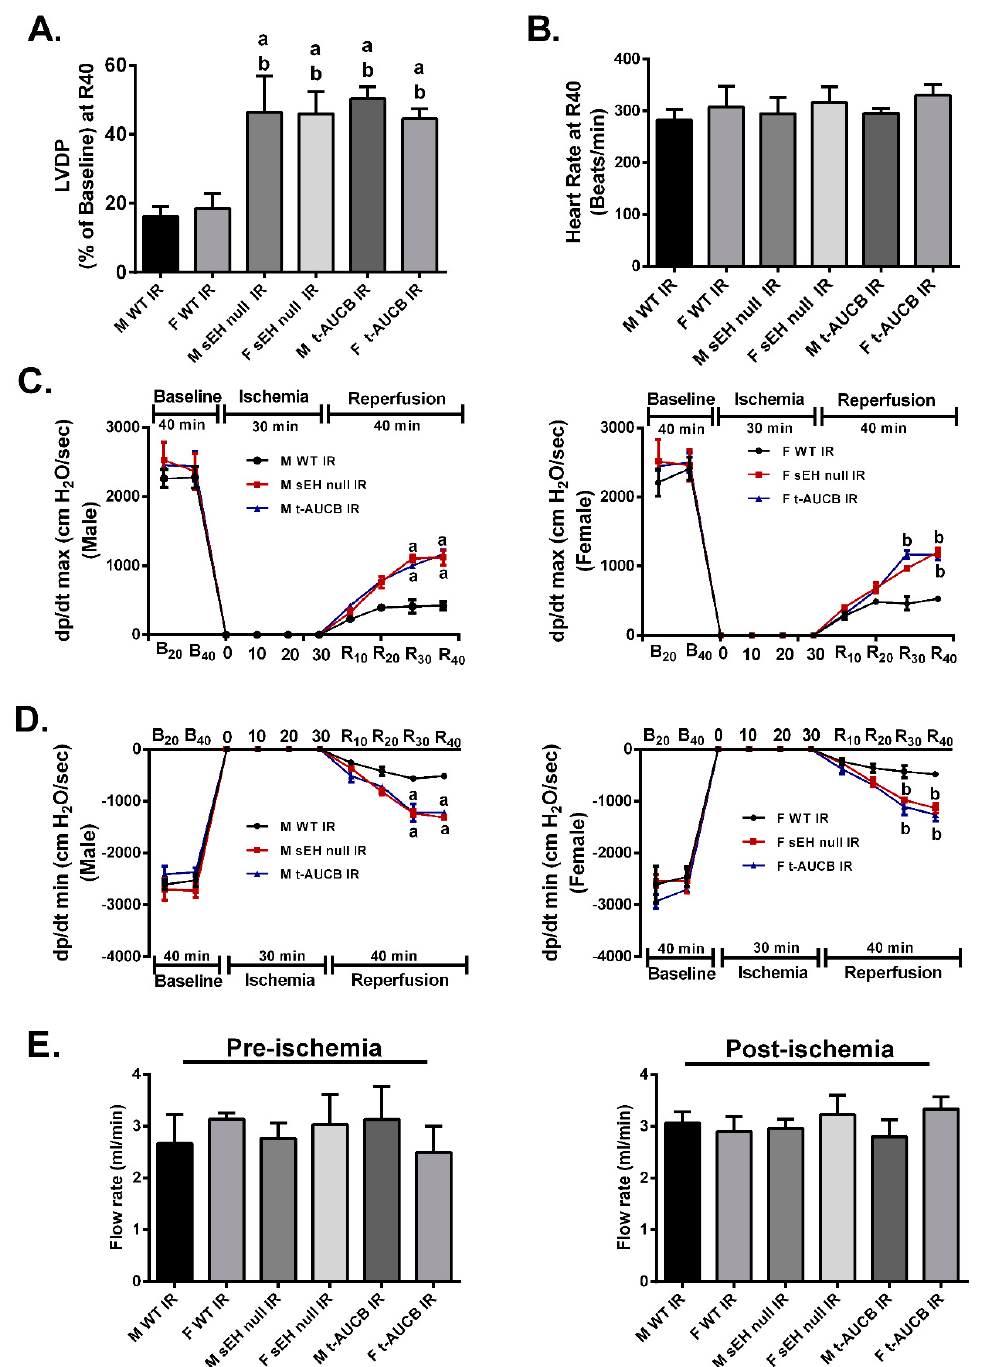
Figure 1. Genetic deletion of Ephx2 or pharmacological inhibition ( t -AUCB) of soluble epoxide hydrolase (sEH) improved post-ischemic contractile parameters in both males and females. ( A ) Left ventricular developed pressure (LVDP) recovery at 40 min of reperfusion as a percentage of baseline, ( B ) heart rate assessed as beats per minute (BPM) at the end of reperfusion (R40), ( C ) rate of contraction (dP/dt max), ( D ) rate of relaxation (dP/dt min) in both male and female hearts at the baseline before (B20) and after (B40) drug treatment, at ischemia, and at 10, 20, 30 and 40 min reperfusion (R10, R20, R30, and R40), and ( E ) coronary flow rates from perfused hearts both pre- and